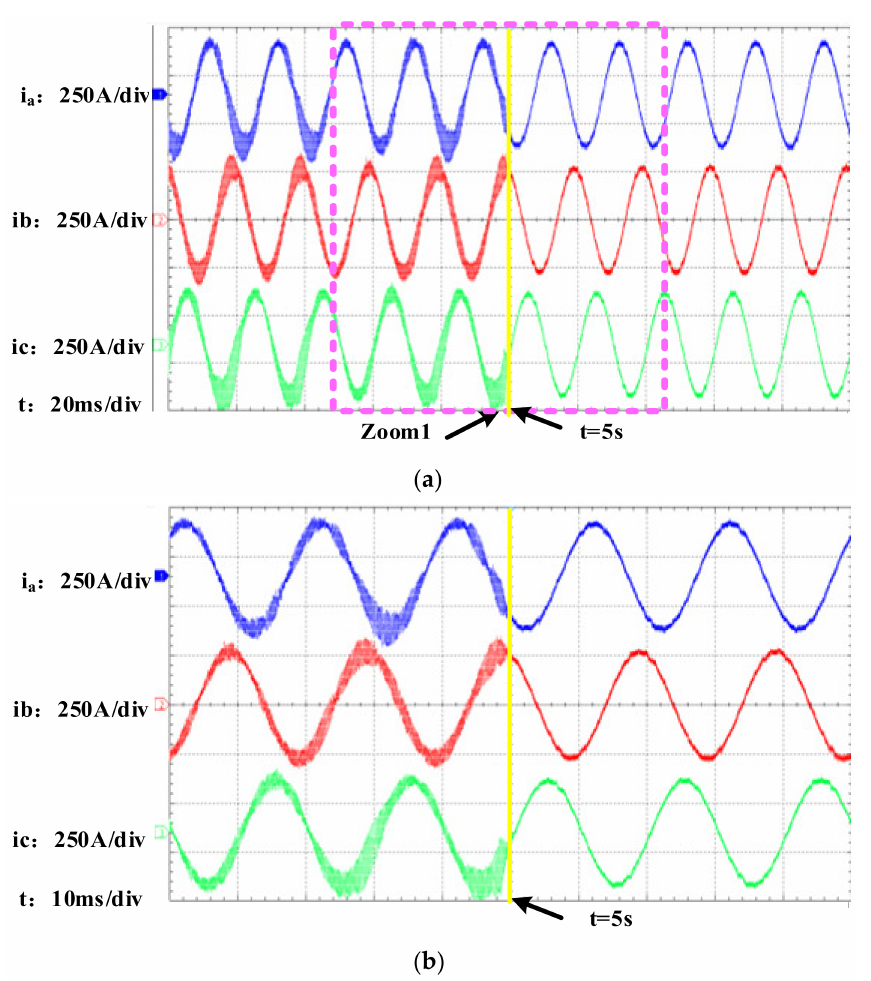
Figure 17. Photovoltaic cluster inverter from resonance to dynamic stable grid current waveform. ( a ) Replacing traditional controller with the proposed DOB at t = 5 s; ( b ) the waveforms of Zoom